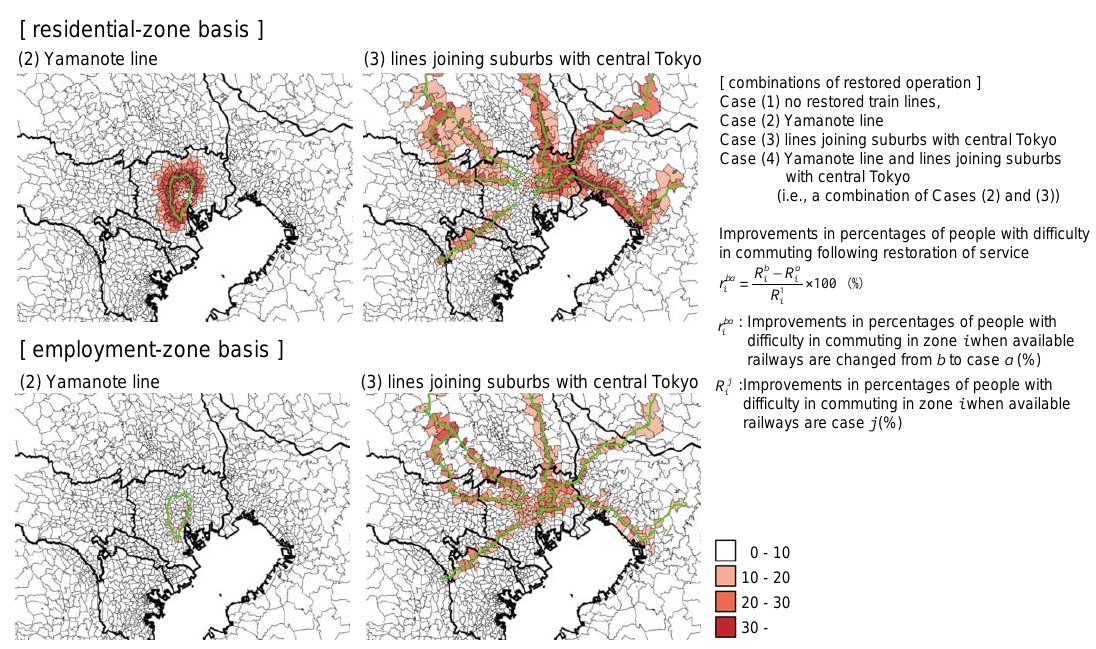
Figure 18. Improvements in percentages of commuting difficulty based on a full recovery of the central Yamanote belt railway, plus lines linking outlying suburbs with central Tokyo.